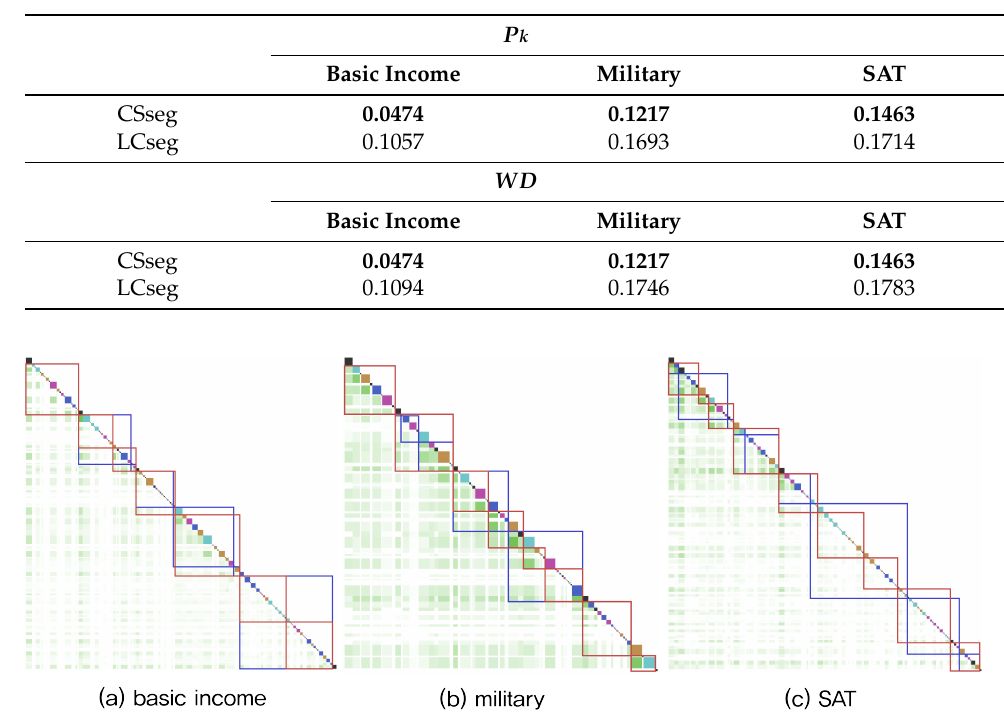
Table 1. P k and WD values of CSseg combined with Plane, Line, and Point and applied with debate consistency metrics, and of the existing model LCseg for multi-party discourse.